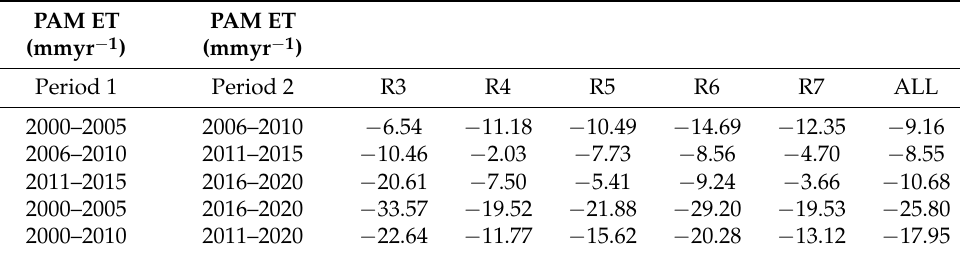
Table 6. The percent change in the total annualized water use, PAM ET (mmyr − 1 ) between two periods, Period 1 compared to Period 2, which are comprised of groups of years 2000–2010, 2011–2020, All reaches along the Lower Colorado River. Note: all the calculated percent change is negative ( − ) and indicate decreases in PAM